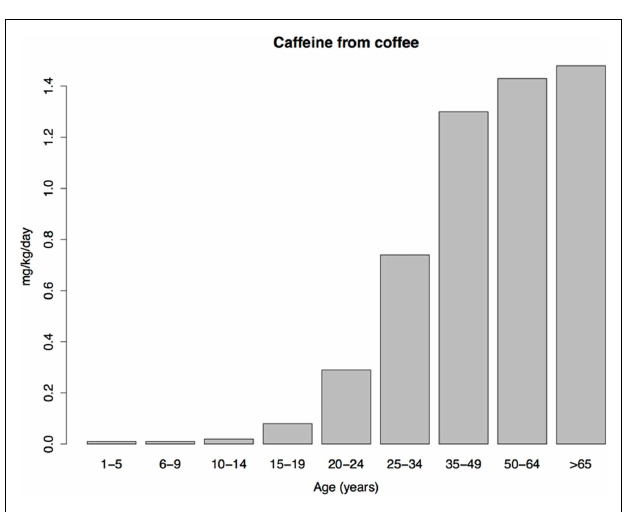
FIGURE 3 | Daily caffeine intake from coffee per kilogram of body weight in a sample of US caffeine consumers . Data from Ref.